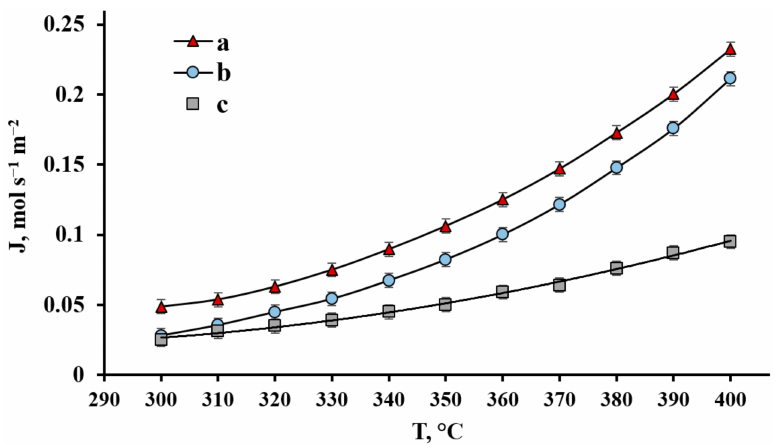
Figure 4. Temperature dependence of the hydrogen flux at ∆ p = 0.1 MPa through a PdCu–Nb–PdCu membrane modified with a nanostructured coating (a) and non-modified membrane (b) and a regular Pd membrane